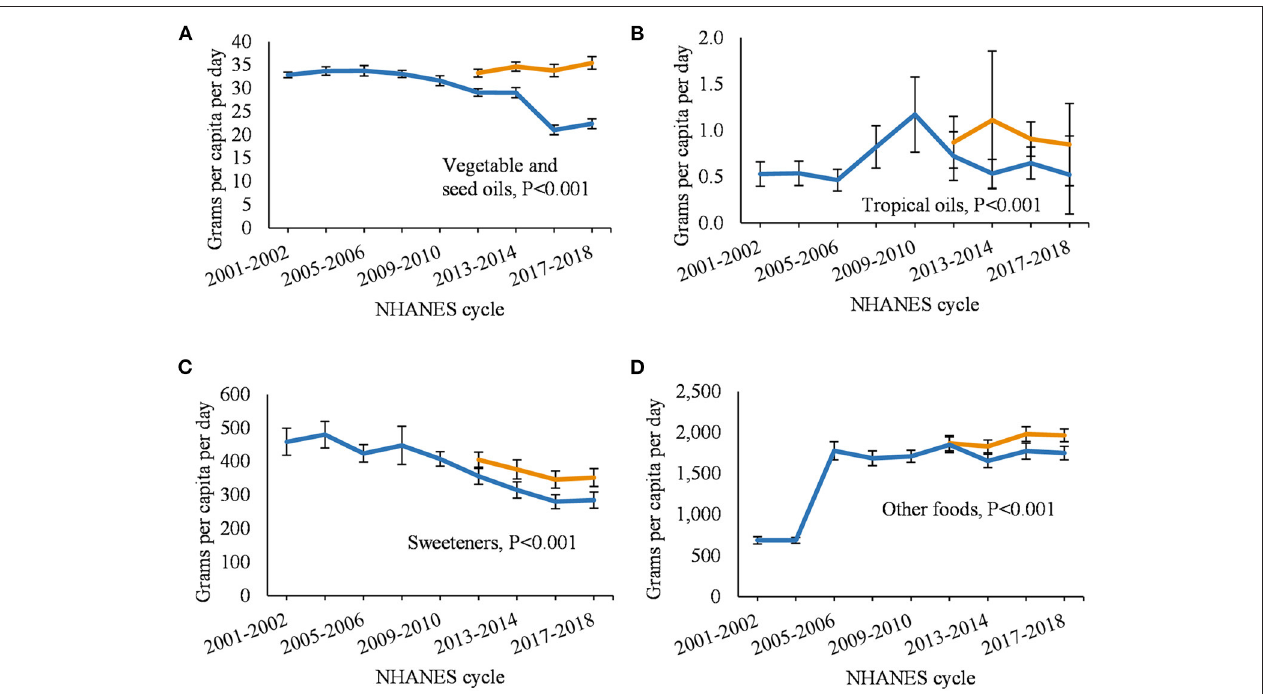
FIGURE 4 | Annual per capita food intake among US adults from 2001 to 2018 comparing updated and non-updated Food Commodity Intake Database (FCID). (A) vegetable and seed oils; (B) tropical oils; (C) sweeteners; and (D) other foods. FCID, Food Commodity Intake Database. Differences between trend lines were evaluated using paired Wald tests adjusted for age, gender, energy intake. Data from 2009 to 2010 were used as the regression intercept.